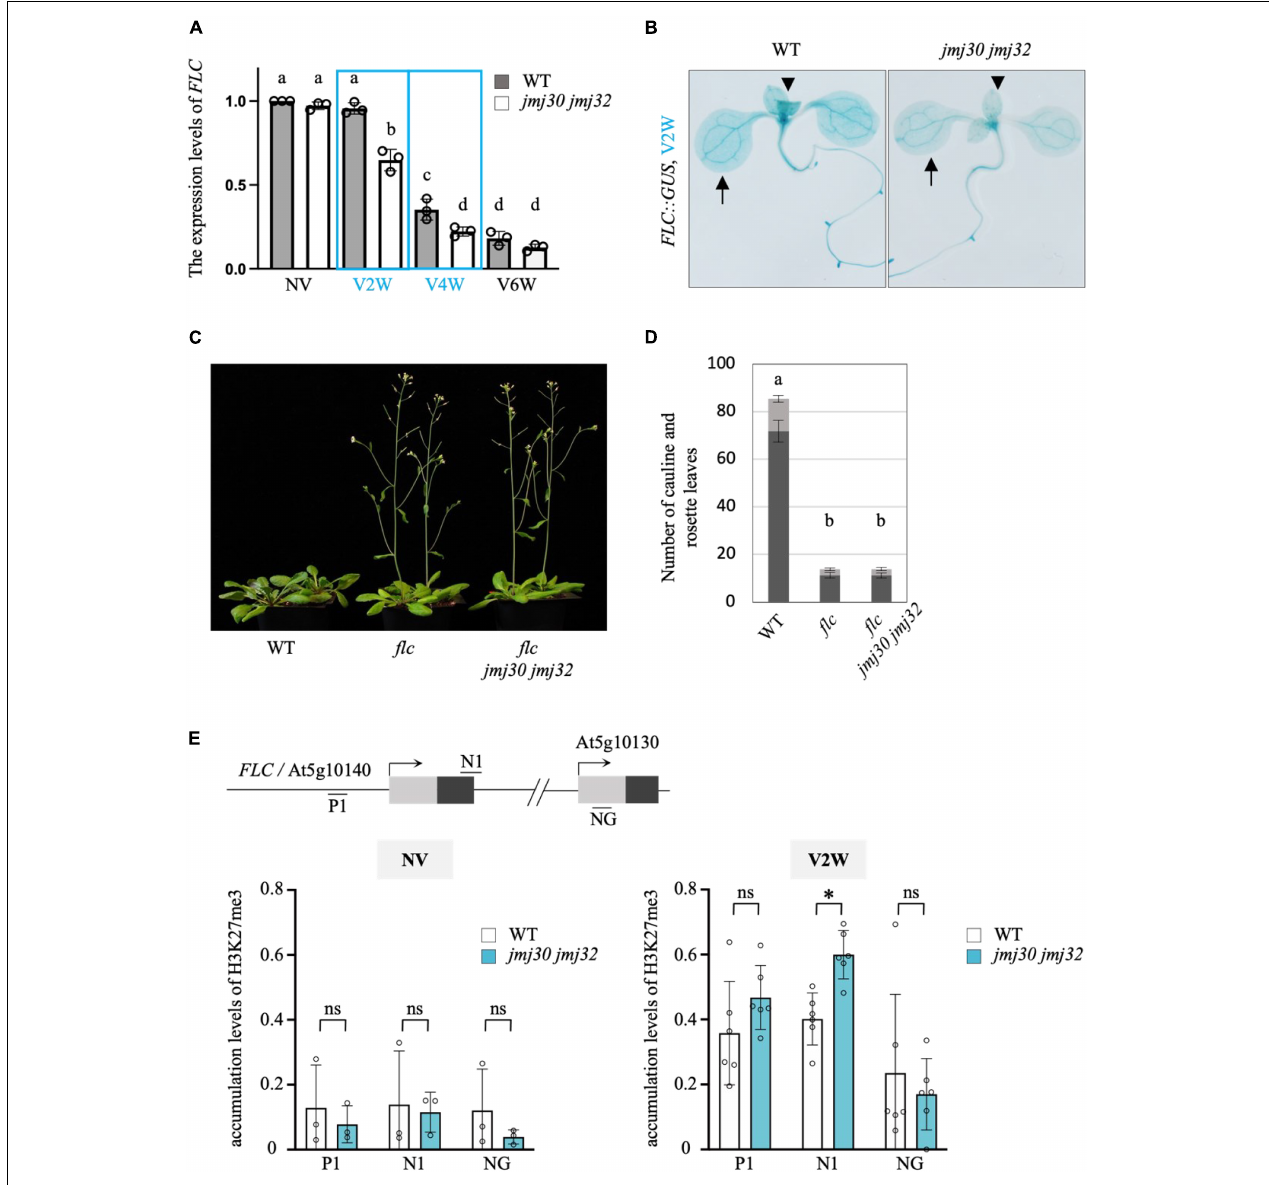
FIGURE 3 | JMJ30 and JMJ32 modulate flowering time through the regulation of FLC during vernalization. (A) The expression levels of endogenous FLC of wild type and jmj30 jmj32 in different vernalized conditions (NV, non-vernalization; V2/4/6W, vernalization at 2/4/6 weeks). Error bars represent SD. One-way ANOVA followed by the Tukey–Kramer test was performed ( p < 0.05). Different letters indicate significant differences, while the same letters indicate non-significant differences. (B) GUS staining of seedlings of FLC::GUS and FLC::GUS jmj30 jmj32 after vernalization for 2 weeks. Arrows indicate cotyledons, and arrowheads indicate true leaves. (C) Photographs of wild type, flc , and flc jmj30 jmj32 in non-vernalized conditions. (D) Quantification of the flowering time of wild type, flc , and flc jmj30 jmj32 under non-vernalized conditions. Number of leaves including cauline (gray) and rosette (black) leaves. Error bars represent SD. One-way ANOVA followed by